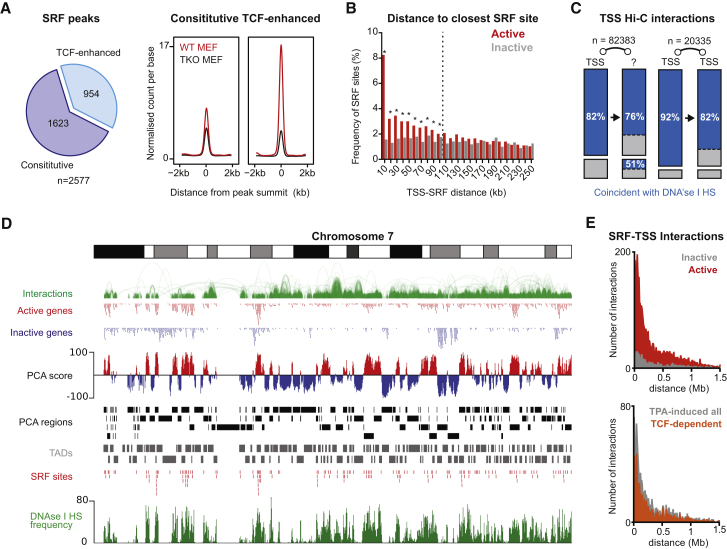
Integration of SRF ChIP-Seq in MEFs with Hi-C Interaction Data(A) The TCFs enhance SRF binding at many sites. Metaprofiles of the SRF ChIP-seq signal at sites where SRF binding is unaffected by TCFs (constitutive) or where they enhance it (TCF-enhanced).(B) Comparison of the frequency of SRF sites at increasing distances from active and inactive gene TSSs (10-kb bins). ∗, significant at p < 0.05 (multiple t test with Holmes-Sidak correction).(C) Most TSS Hi-C interactions in MEFs coincide with DNase I HS at 10-kb resolution. Left: TSS interactions with non-TSS regions. Right: TSS-TSS interactions. Blue, interactions involving regions containing at least one DNase I HS.(D) Hi-C analysis. Chromosome 7 is shown with tracks as follows: significant Hi-C interactions displayed using the WashU EpiGenome browser; active (red) and inactive (blue) RefSeq-annotated genes identified by RNA-seq; PCA analysis of Hi-C data with A regions (positive PCA score) shown in red and B regions (negative PCA score) in blue; comparison of individual PCA regions (black) with the TADs (gray) previously annotated in MEFs (Battulin et al., 2015); SRF binding sites; and DNase I HS frequency per base.(E) The relation between TSS-SRF interaction distance in Hi-C and gene activity defined by RNA-seq. Top: interactions involving active (red) or inactive (gray) TSSs. Bottom: interactions with TPA-induced TSSs; those whose induction is TCF-dependent are highlighted in orange.See also Figure S2.